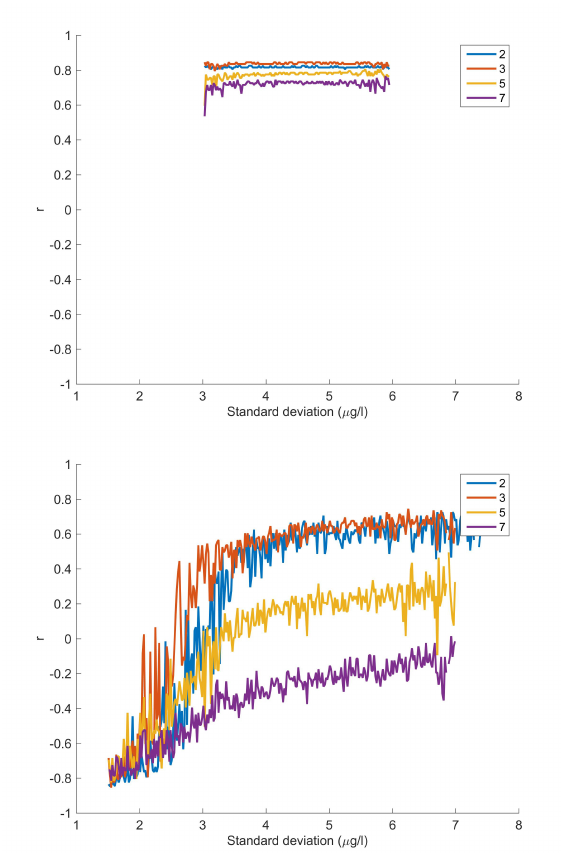
Figure 10. Correlation coefficient r for different number of wavelength bands as variables. 30 (top) and 8 (bottom) randomly selected reference samples. Both figures: 50000 random selection and probability level 0.05.